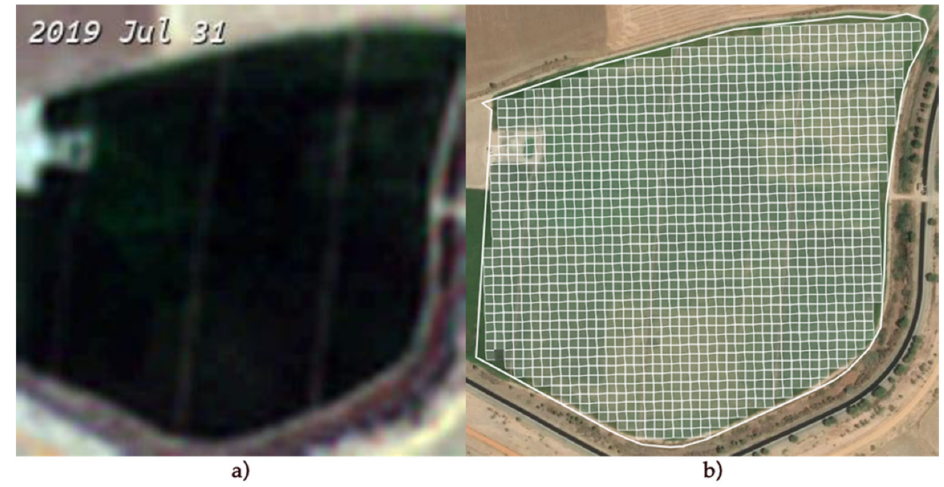
Figure 1. Pixel grid of a corn crop. Image ( a ) is an image extracted from Sentinel-2 as of 21 July 2019; Image ( b ) represents the pixels of a plot.